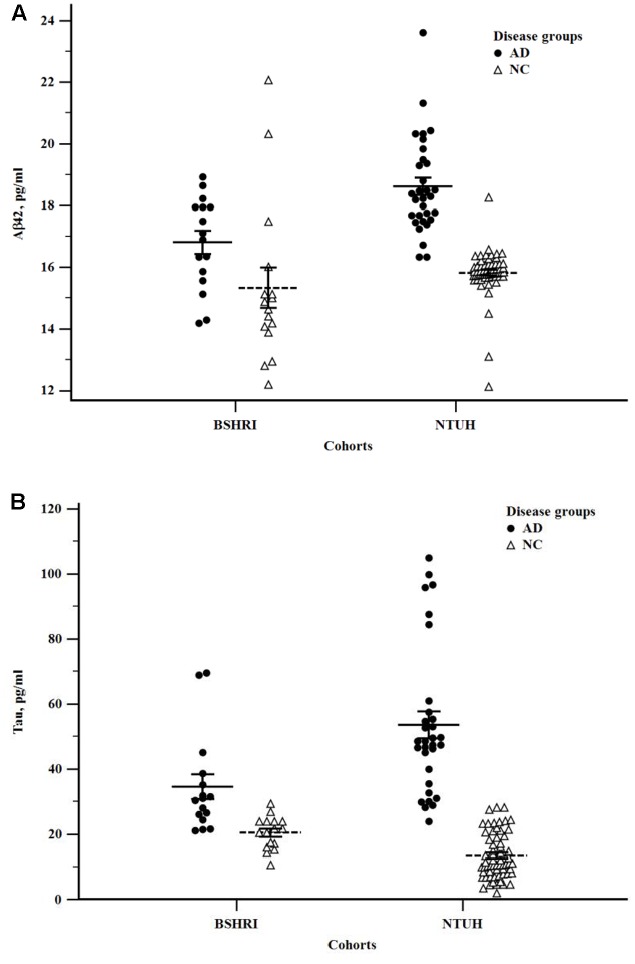
Scatter plots of Aβ42 (A) and tau (B) levels in the Banner Sun Health Research Institute (BSHRI) and National Taiwan University Hospital (NTUH) cohorts by disease groups.